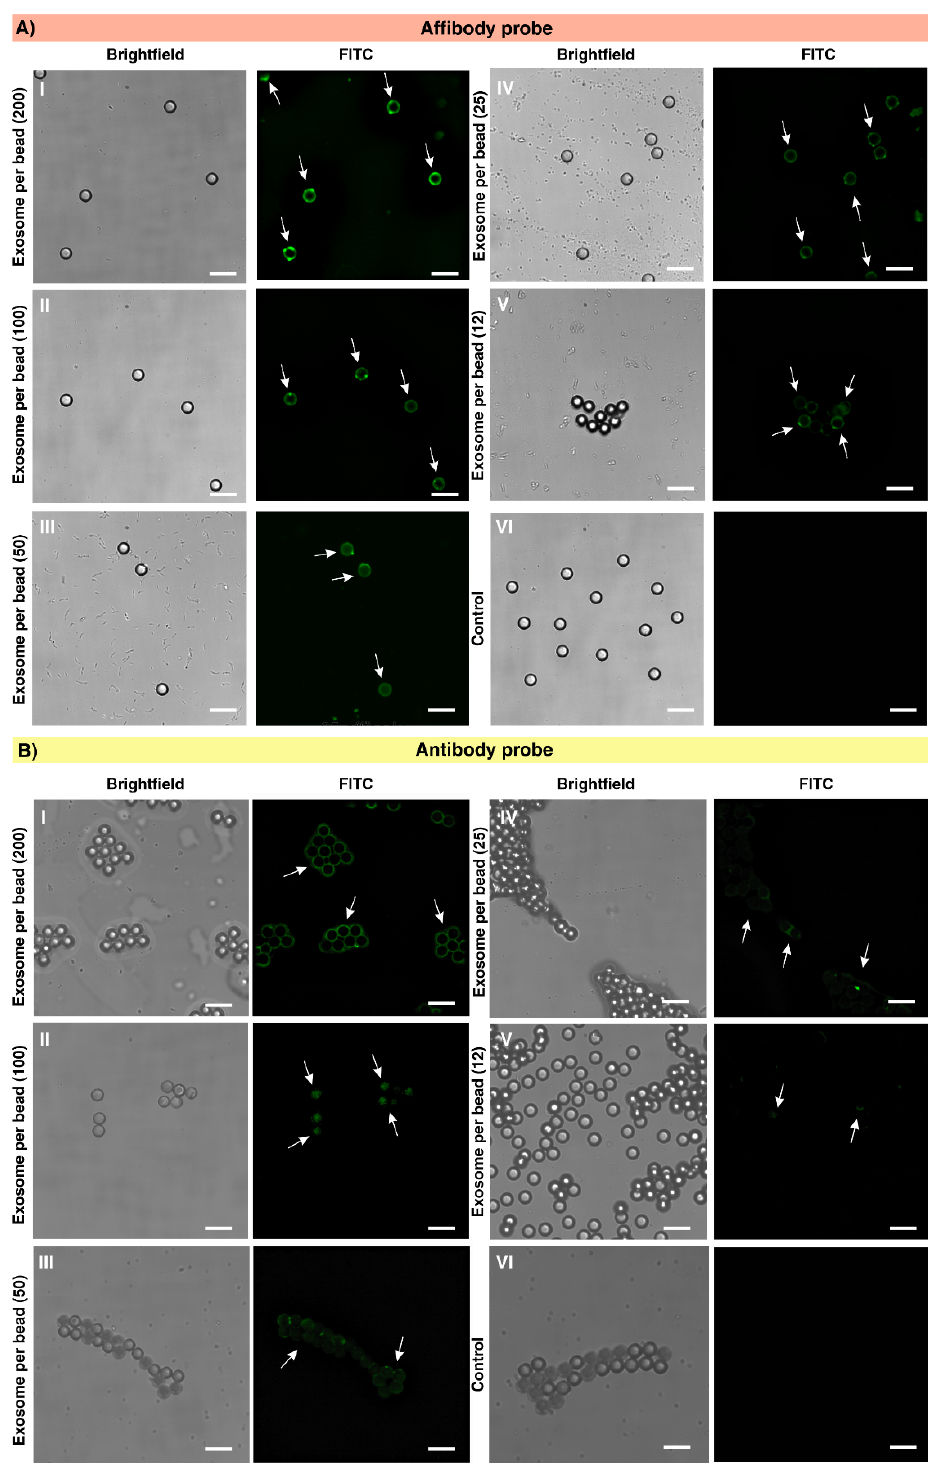
Figure 6. Bright field and fluorescence microscopy images of captured exosomes with ( A ) AffiBeads probe in ratio of I 200, II 100, III 50, IV 25, and V 12 exosomes per bead using a FITC filter and ( B ) anti-EGFR antibody-coated microbeads for I 200, II 100, III 50, IV 25, and V 12 exosomes per polystyrene microbeads. ( VI ) In both of the AffiBeads and carboxylate polystyrene beads coated with anti-EGFR platforms, the BSA was used instead of exosomes as control. (Scale bar: 20 µ